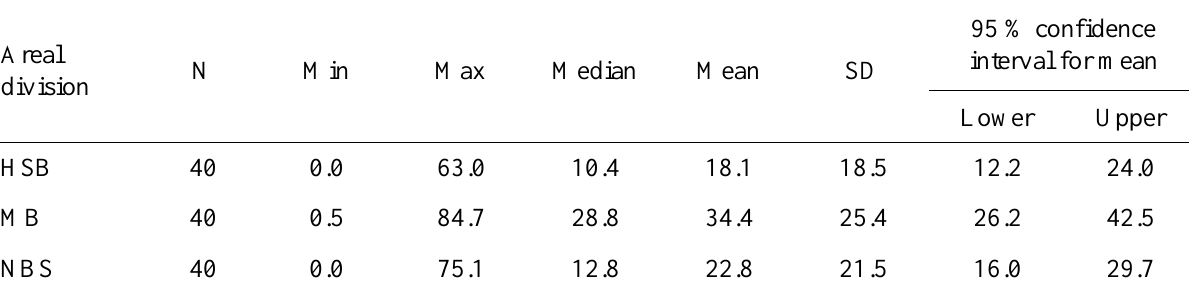
Table 6. Drained proportion of an aapa mire complex (%).